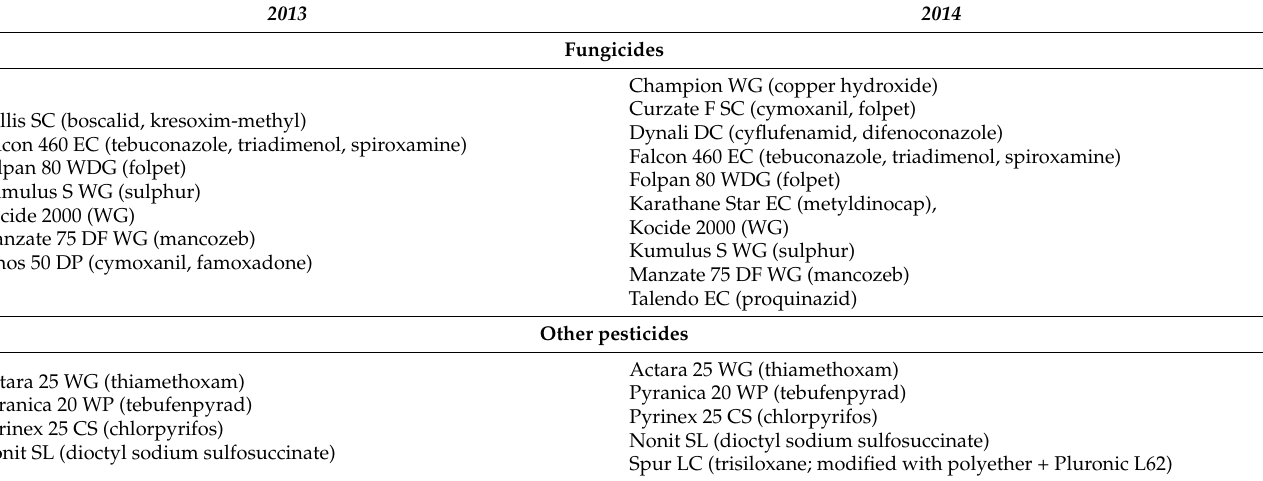
Table A1. Pesticides applied in the CT treatment with active ingredients in 2013 and 2014.